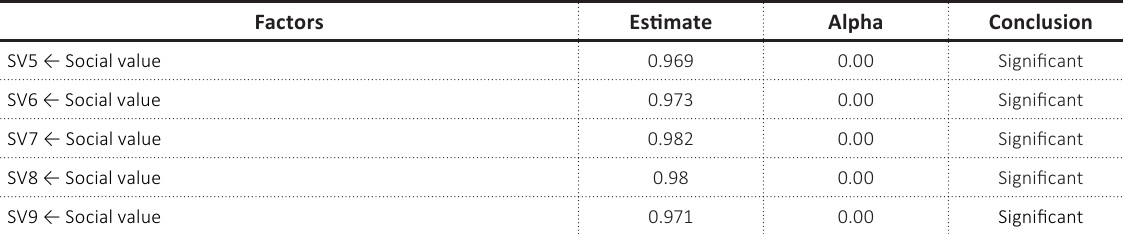
Table 2. Validity of loading factor and significance of social value